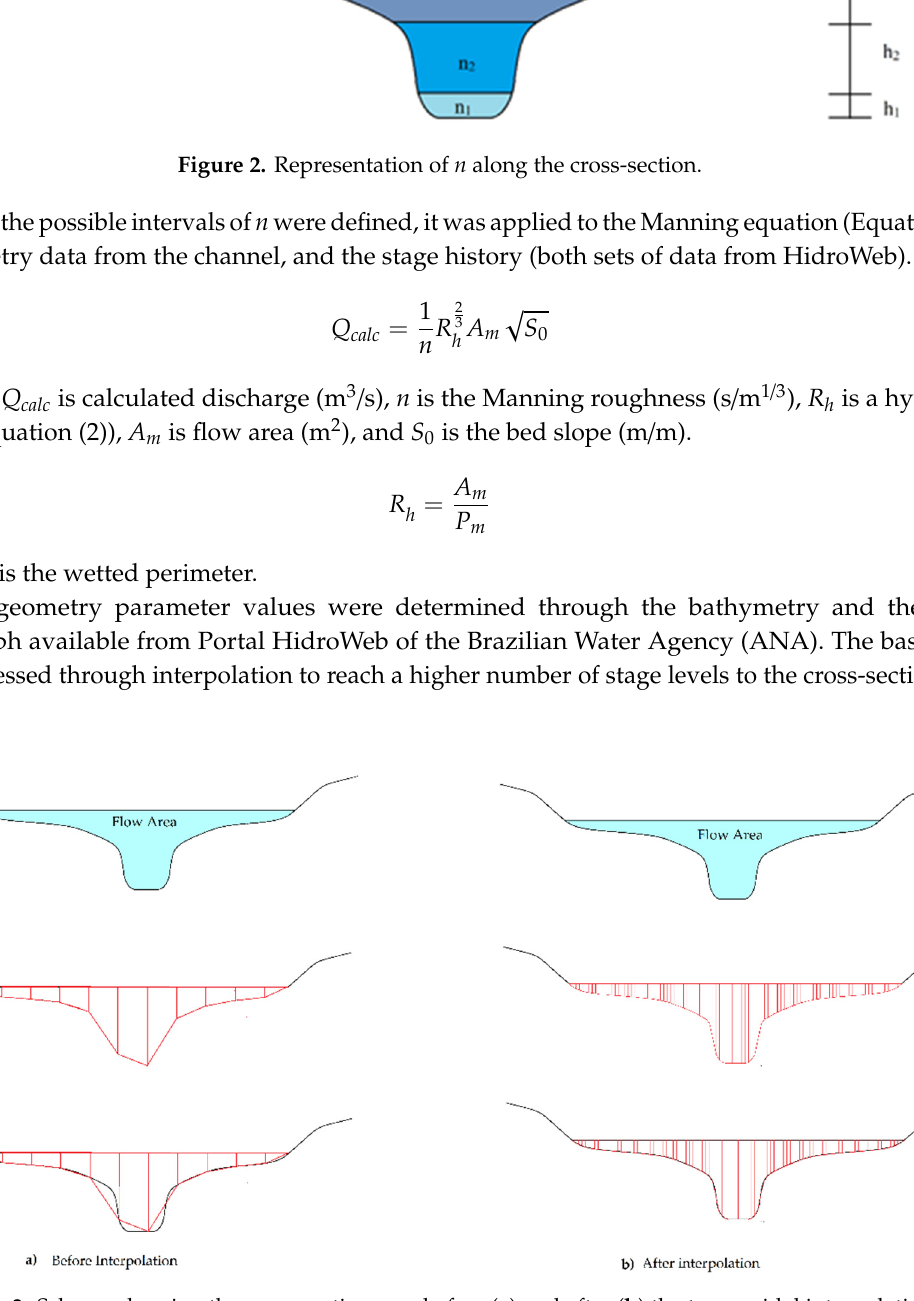
Figure 1. Meia Ponte River’s and study area.